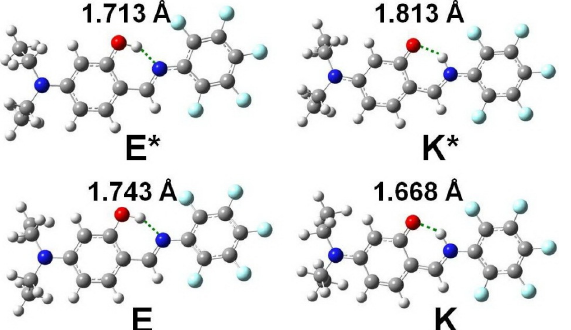
Figure 9. The optimized geometric structures of enol (E) and keto (K) form for 4 in the ground (S 0 ) and the first singlet excited state (S 1 ) together with the intramolecular hydrogen bond lengths.